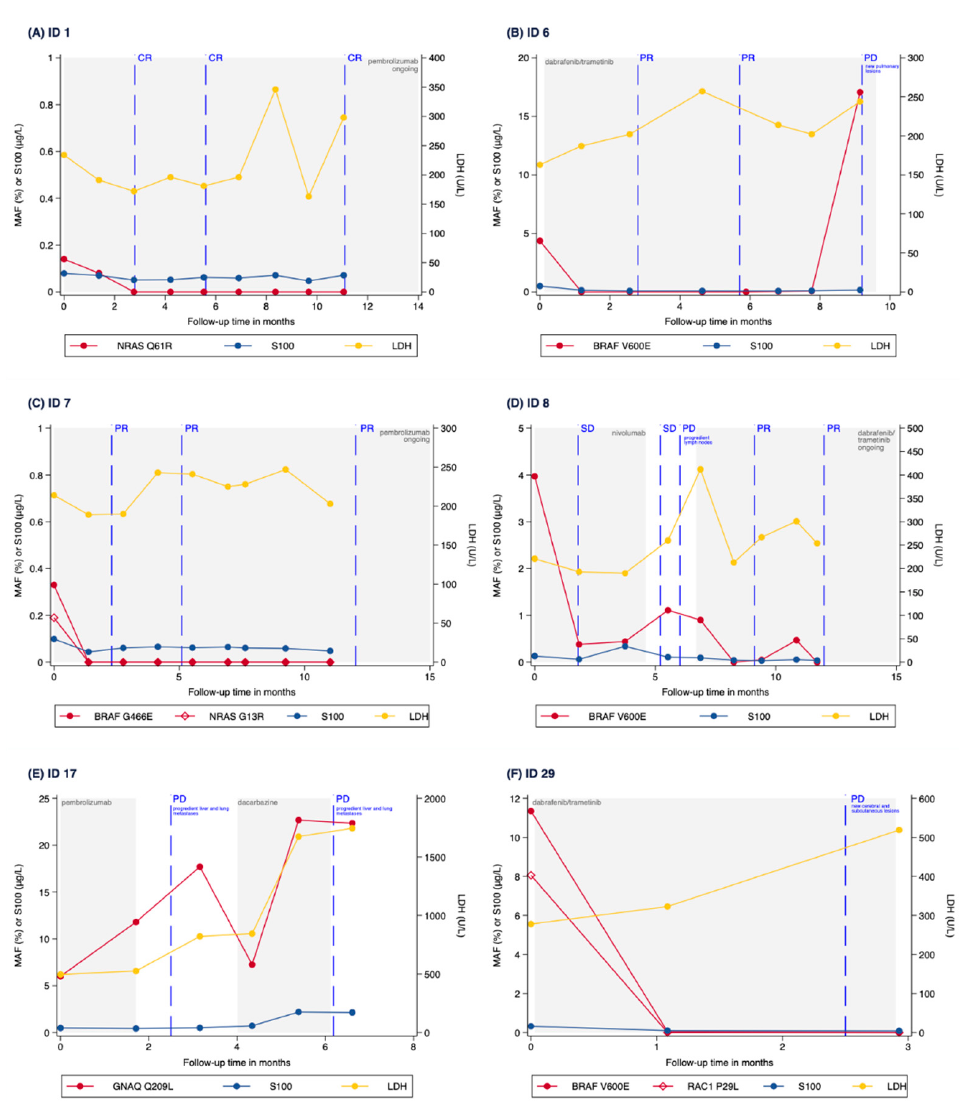
Figure 6. ( A ) Time course of a patient (ID 1) with MAF levels monitored through a NRAS Q61R mutation during pembrolizumab treatment. MAF decreases under pembrolizumab treatment and becomes undetectable, while radiologically displaying complete response to treatment. ( B ) Time course of a patient (ID 6) with MAF levels monitored through a BRAF V600E mutation in plasma during dabrafenib/trametinib treatment. MAF decreased and became undetectable prior to radiological evidence of partial response to treatment. In the further course, MAF increased again, while CT scans showed newly developed lesions in the lung. ( C ) Time course of a patient (ID 7) with MAF levels monitored through both a BRAF G466E and a NRAS G13R mutation in plasma during pembrolizumab treatment. MAFs of both mutations fell and became undetectable after initiation of pembrolizumab, preceding CT scans displaying partial response to treatment. ( D ) Time course of a patient (ID 8) with MAF levels monitored through a BRAF V600E mutation in plasma during nivolumab and subsequent dabrafenib/trametinib treatment as well as during a treatment pause in between. The MAF of the BRAF mu- tation rose before radiological disease progression and fell after change of treatment regimen. ( E ) Time course of a patient